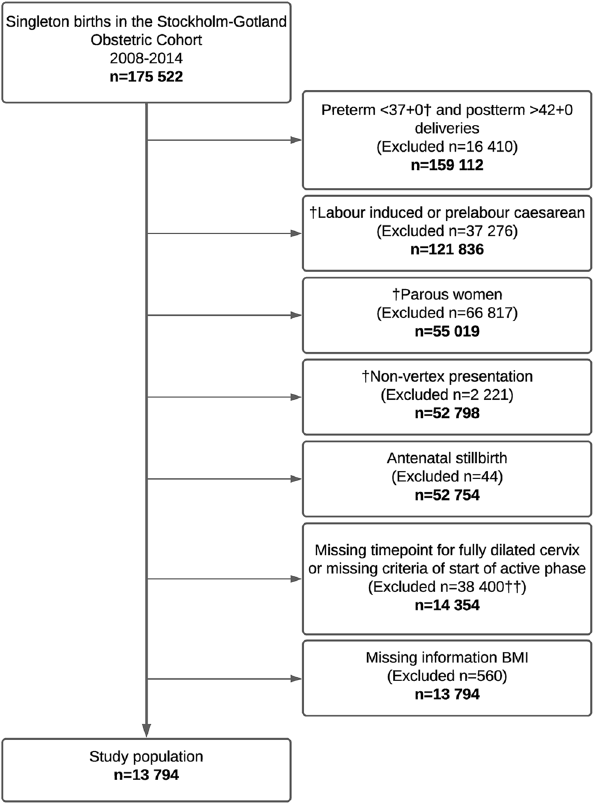
Figure 1. Flowchart of cohort selection. † Conditions indicated to fulfill the Robson 1 criteria. †† Including 557 women with caesarean delivery in first stage. n corresponds to numbers left after exclusions. Women in latent labour at admission were not included in the final study population since they did not fulfil the definition of start active phase. BMI body mass